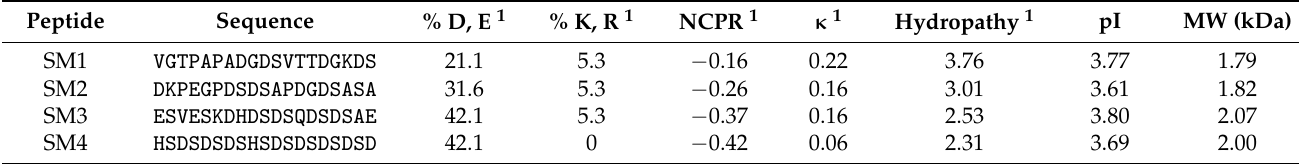
Table 2. Properties of Starmaker (SM) peptides.